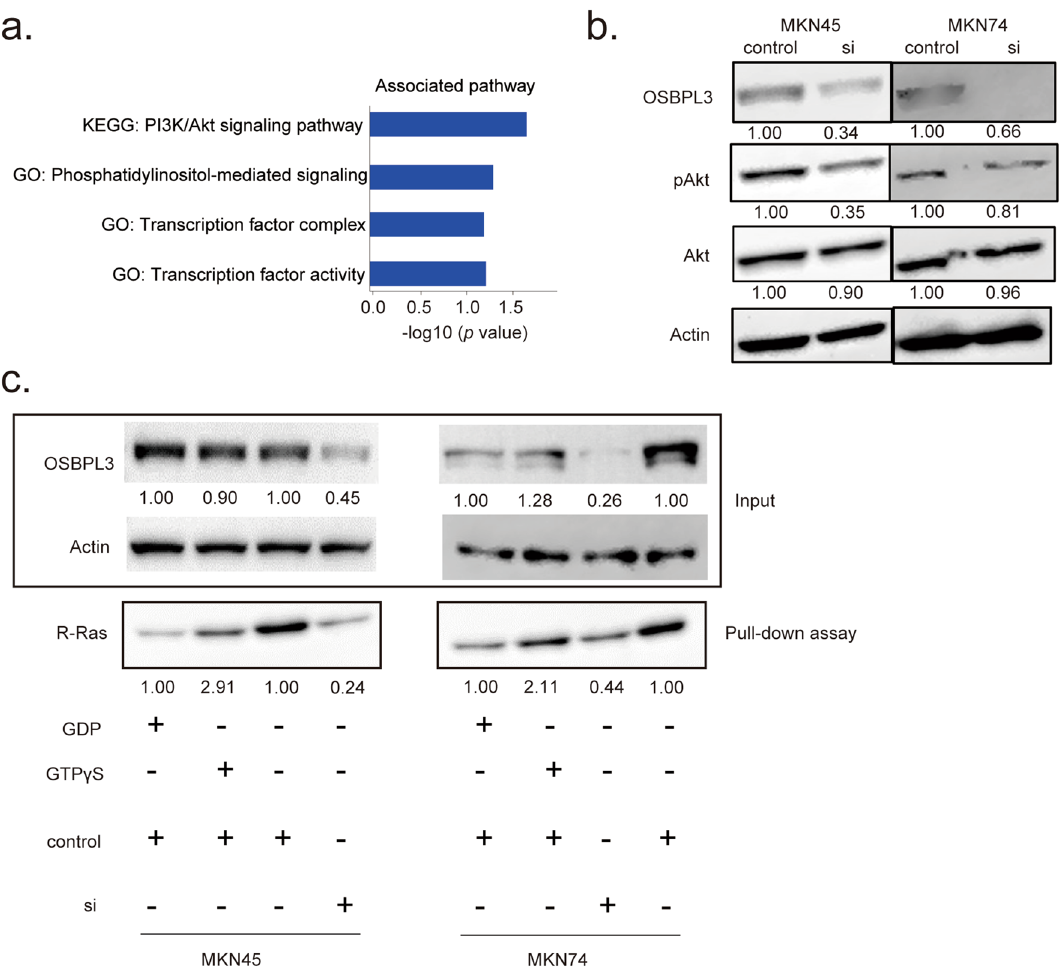
Figure 4. Role of OSBPL3 in activating the R-Ras/Akt signaling pathway in GC cells. ( a ) Pathway analyses of OSBPL3 gene using the DAVID online tool. ( b ) The protein levels of OSBPL3, pAkt, total Akt, and actin in GC cells (MKN45 and MKN74) transfected with siRNAs. si: siRNA targeting OSBPL3 . ( c ) Active R-Ras pull-down assay in GC cells (MKN45 and MKN74) transfected with siRNAs. si: siRNA targeting OSBPL3